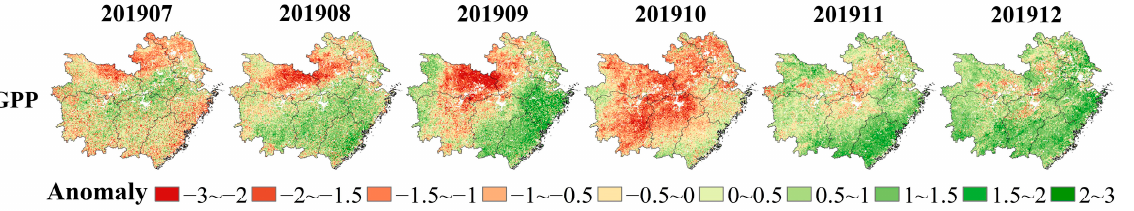
Figure 12. Spatial distributions of the standardized anomaly of GPP from July to December 2019.